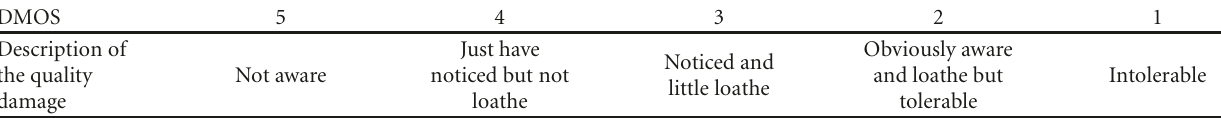
Table 10: DMOS score category description-DCR test.